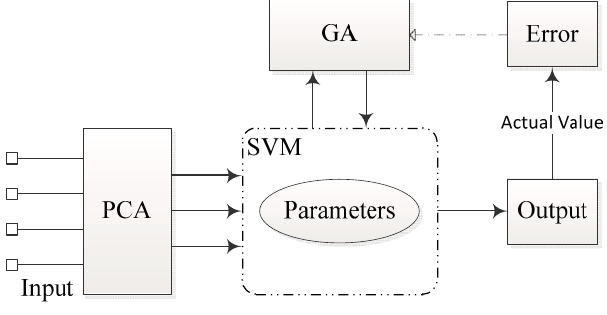
Figure 12. Flow-chart of the hybrid